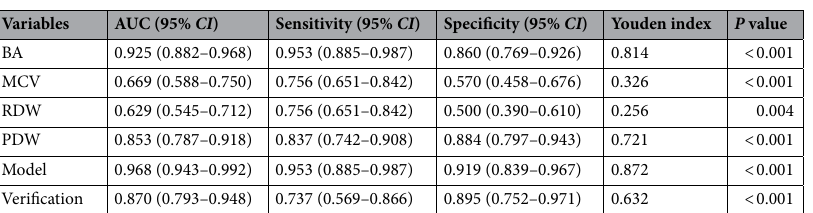
Table 3. Characteristics of the receiver operating characteristic